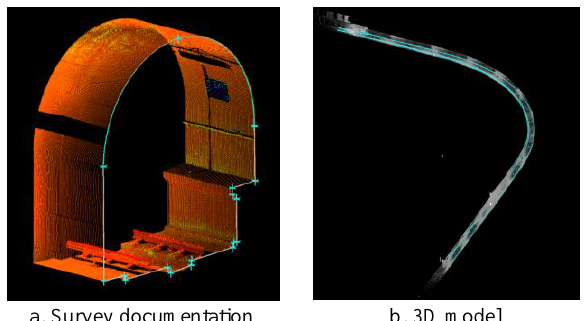
Figure 8. Documentation of the